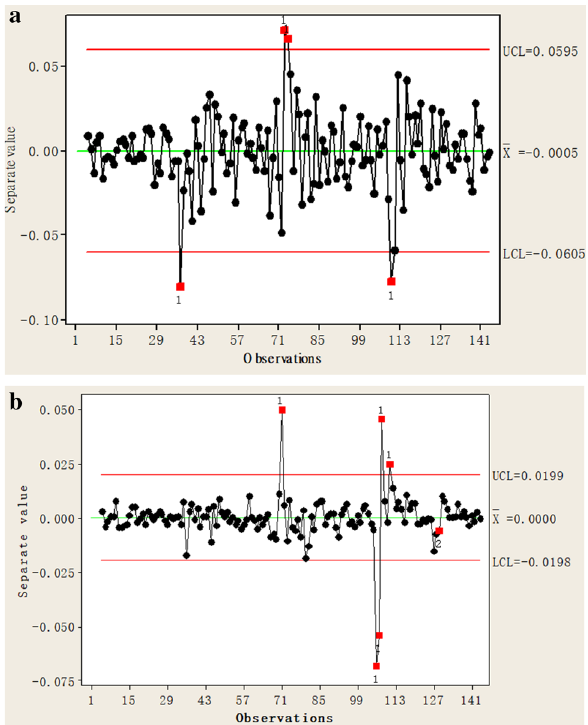
Figure 1. ( a ) One-way control chart of the open process for minor fault samples. (Calculated by Minitab 16.0 version (Minitab Inc.)). ( b ) One-way control chart of the closed process for minor fault samples. (Calculated by Minitab 16.0 version (Minitab